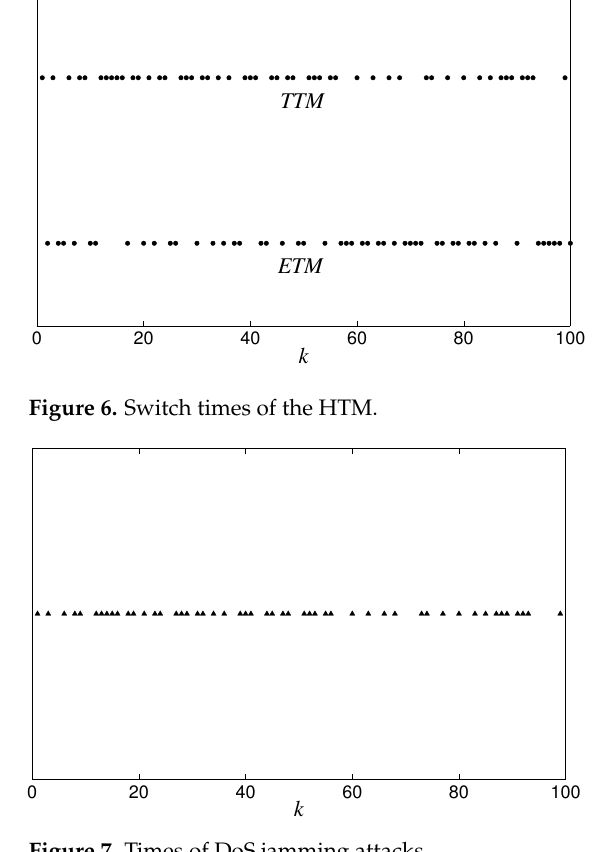
Figure 7. Times of DoS jamming